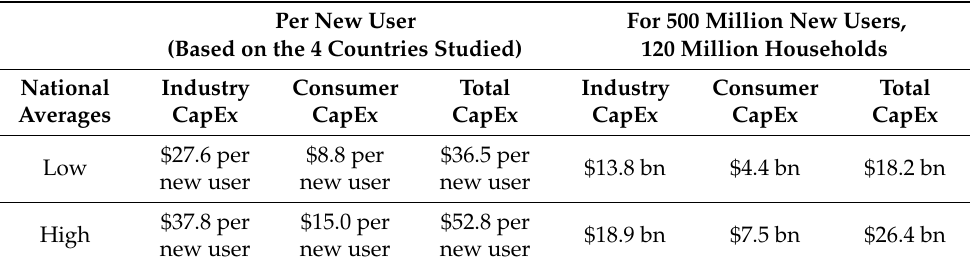
Table 7. Industry and consumer capital investment for serving new LPG users